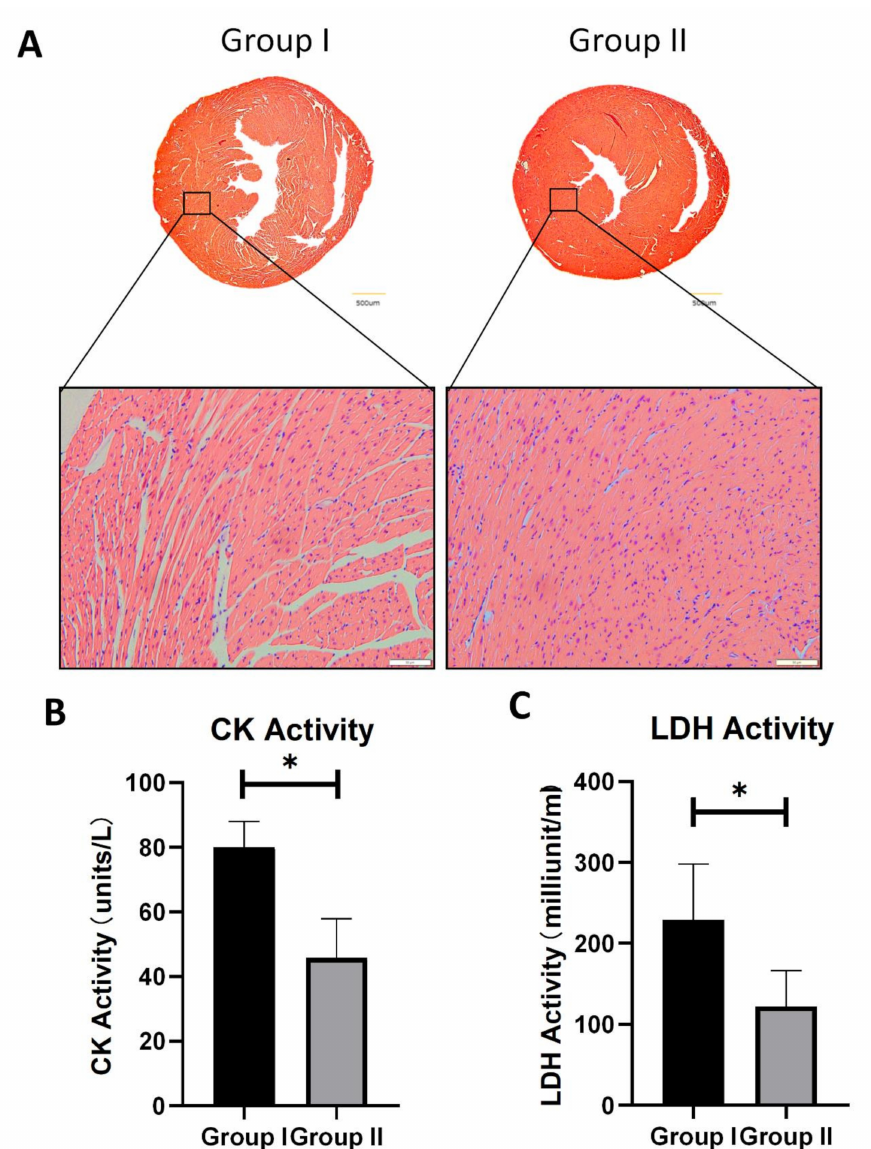
Figure 3. Heart damage evaluation of two groups after 6 h HTK preservation. ( A ) Representative H&E staining of two groups. Scale bar indicates 500 µ m and 50 µ m, respectively. ( B ) Creatine kinase activity level in HTK solution of two groups after 6 h preservation. ( C ) LDH activity level in HTK solution after 6 h preservation. N = 4–5, * p <